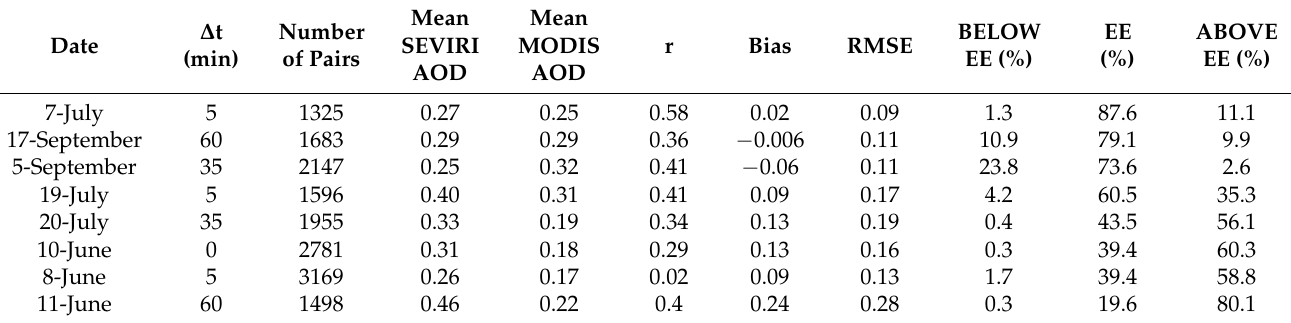
Table 6. Statistics: SEVIRI AOD vs. MODIS AOD—Czech Republic.